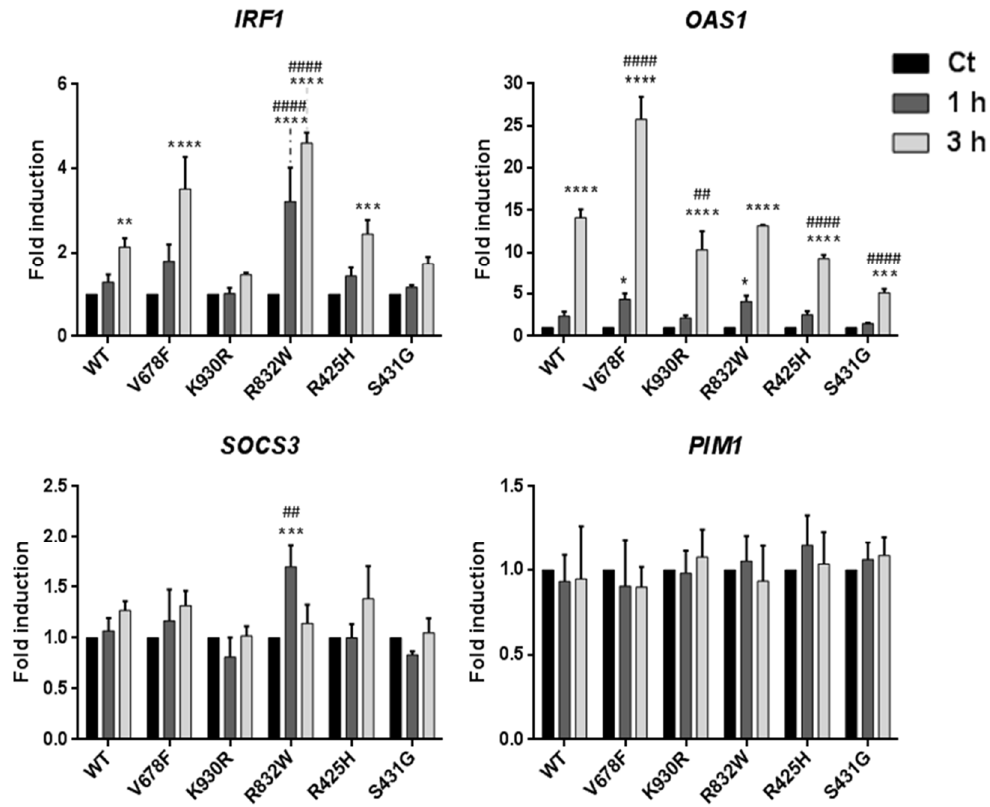
Figure 3. STAT-target gene expression induced by IFN α in U1A cells expressing TYK2 variants. Cells were treated with 500 pM IFN α . Total RNA was extracted, reverse-transcribed, and analysed by RT-qPCR for the indicated genes. Values were normalised to GAPDH and are expressed as n -fold versus untreated cells for each variant. Mean values of three independent experiments ± SD are shown. Two-way ANOVA was used for statistical analysis, performing post hoc Bonferroni tests for intergroup differences. * For each variant, comparison between the indicated time and untreated cells; # for each time condition, comparison between each variant and WT. For * and #: * p < 0.05; ** p < 0.01; *** p < 0.001; **** p <0.0001.